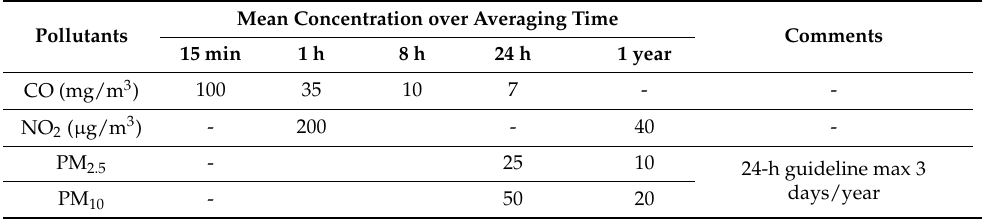
Table 6. Guidelines on Household Air Quality, WHO